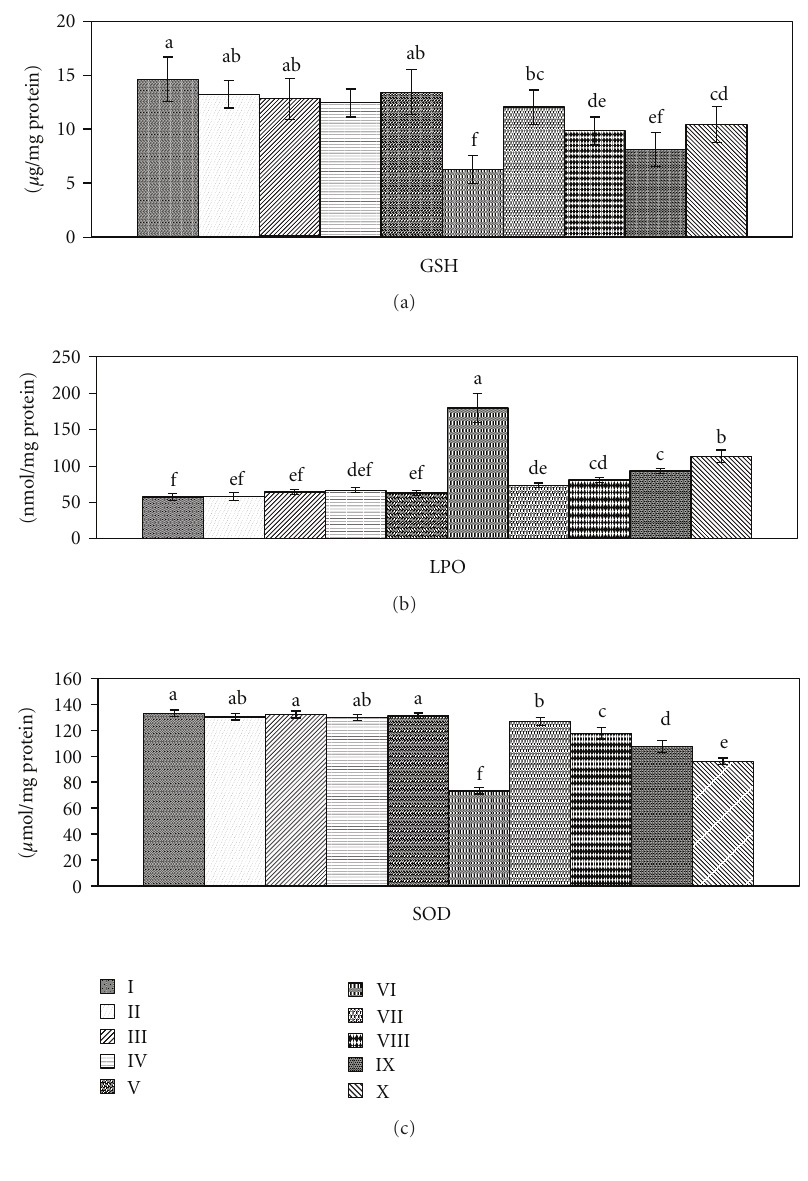
Figure 1: E ff ect of Zingiber o ffi cinale on antioxidant levels: glutathione (GSH), lipid peroxides (LPO) and superoxide dismutase (SOD). Groups I: control, II: control treated with ethanol extract, III: control treated with chloroform extract, IV: control treated with petroleum ether extract, V: control treated with silymarin, V1: intoxicated with CCl 4 , VII: intoxicated with CCl 4 and treated with ethanol extract, VIII: intoxicated with CCl 4 and treated with chloroform extract, IX: intoxicated with CCl 4 , treated with petroleum ether extract, and X: intoxicated with CCl 4 and treated with silymarin. Data are mean ± SD of six rats in each group. Statistical analysis is carried out by one-way analysis of variance (ANOVA); Costat Computer Program. Unshared letters are significance values between groups at P < 0 .